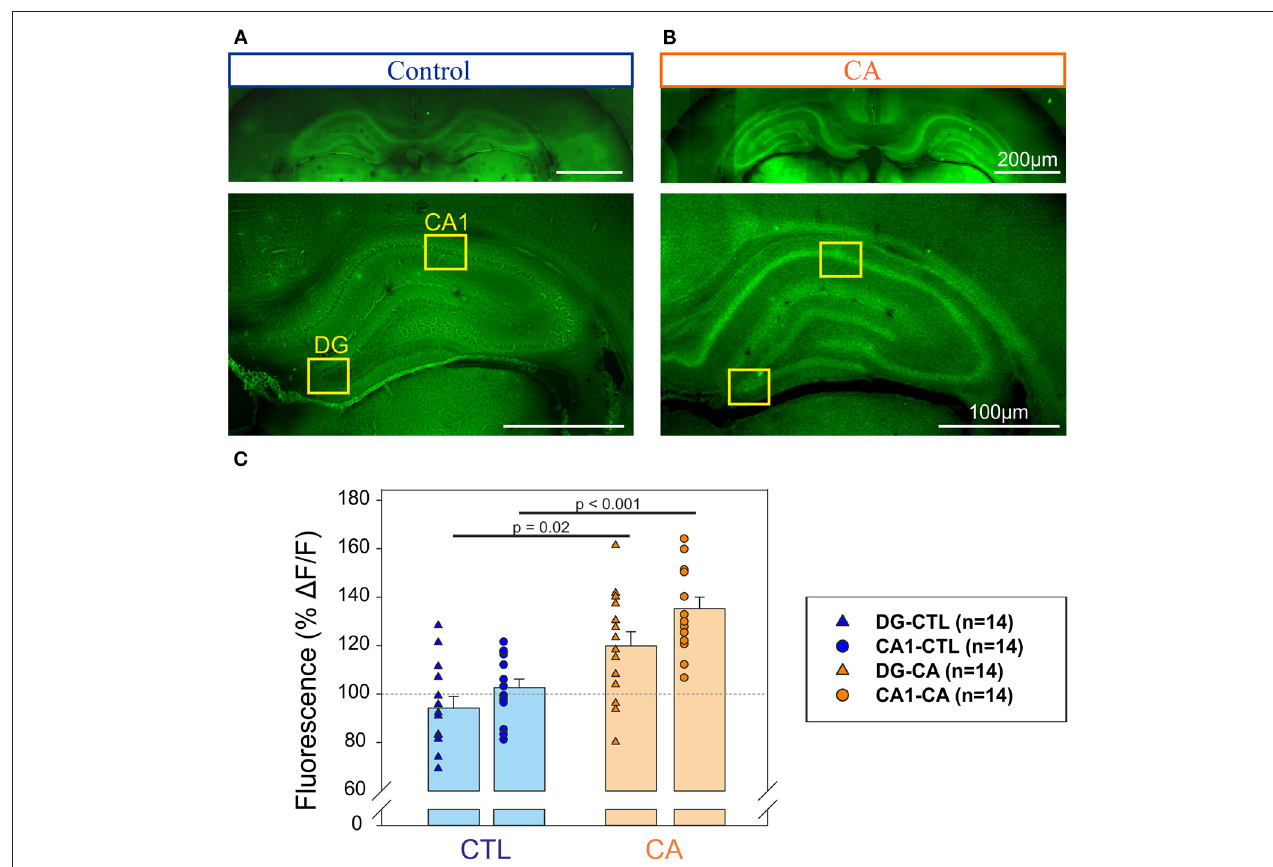
FIGURE 3 | Detection of neurodegeneration in the hippocampus with Fluoro-Jade. Photographs of coronal slices obtained for control animals (A) and animals exposed to a CA at Day 1 (B) at two different magnifications (top, bottom). Note that in each case top and bottom images have been obtained from different slices. The yellow rectangles delineate the Dentate gyrus (DG) and the CA1 region of the hippocampus in which fluorescent measurements have been performed to be compared to background signal. (C) Histograms representing the % of relative change of fluorescence ( 1 F/F) in the regions of interest (DG, triangles and CA1, circles) for control ( n = 14, blue symbols) and CA1 ( n = 14, orange symbols). A significantly stronger intensity of fluorescence in the DG and CA1 regions of the hippocampus in the CA tissue, suggesting a higher degree of neuronal